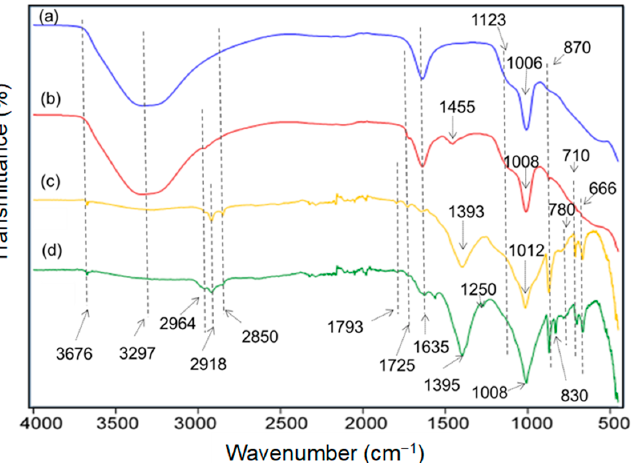
Figure 4. ATR-FTIR spectra of ( a ) potassium water glass ( b ) fresh liquid CF1 ( c ) hardened CF1 and ( d ) hardened CF12.